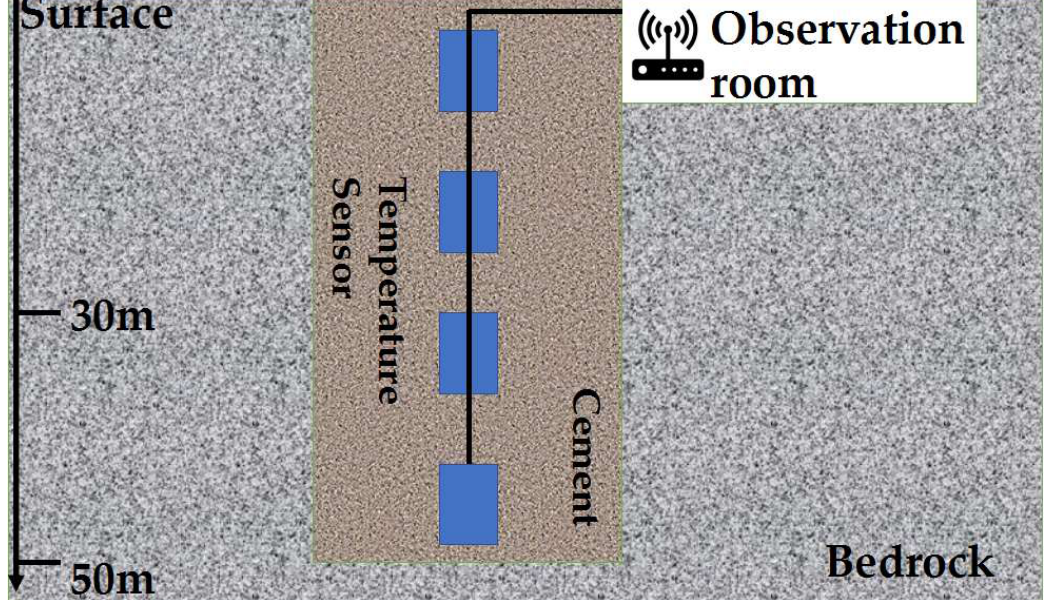
Figure 2. Schematic diagram of the installation of bedrock temperature observation equipment. The brown column is a borehole. The grey area is rock mass. The blue rectangle is the temperature sensor. The arrow direction indicates below the surface.